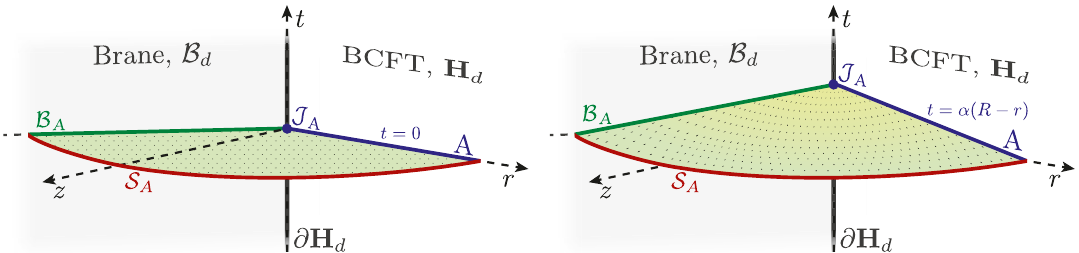
Figure 5. Left: the Cauchy slice, with t = 0, used to show that the integral of (cid:14) N tt on B A vanishes. Right: the Cauchy slice, with t = (cid:11) ( R (cid:0) r ), used to show that the integral of (cid:14) N t(cid:26) on B A